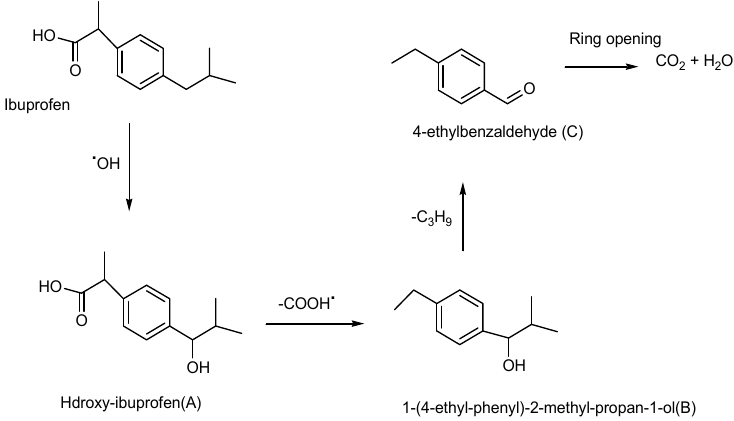
Scheme 2. Proposed degradation mechanism of Ibuprofen by titania and zinc oxide as